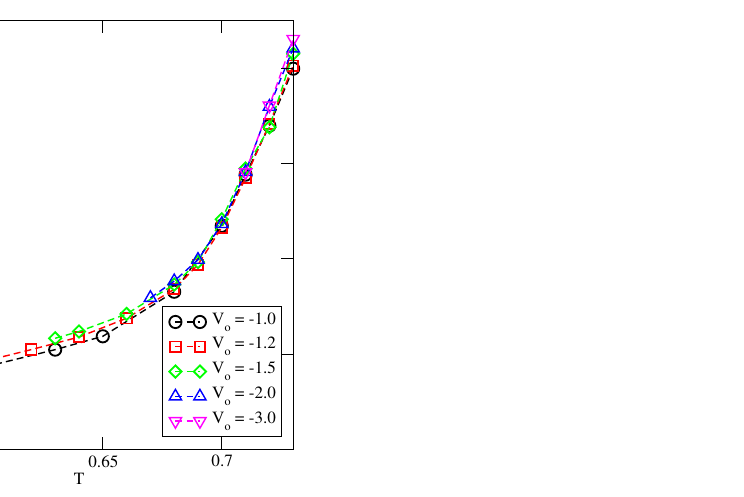
Figure 10. The temperature changes of h max for the systems with u AB = 0, u BB = − 1.0 and different V o (given in the